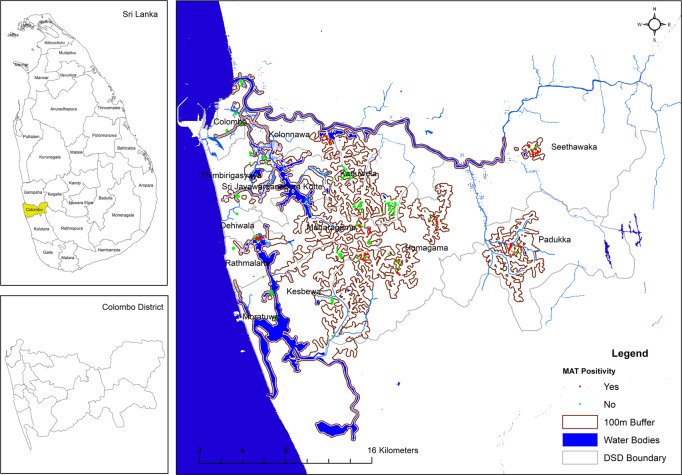
MAT positivity and distribution among water bodies.This image is licensed under the Creative Commons Attribution 4.0 International License (http://creativecommons.org/licenses/by/4.0/).